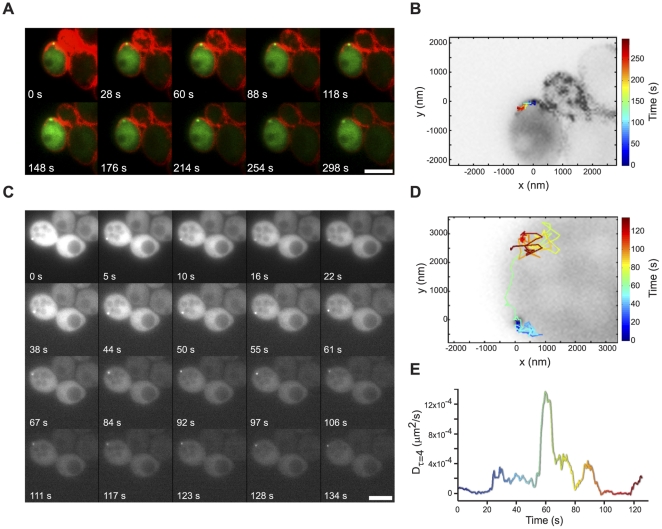
2D dynamics of actin patch mRNA localization.(A) Montage of a time-lapse video of LAS17:MS2 (green) localization in a haploid, early S phase cell with actin patch accumulation at the presumptive bud indicated by FM4–64 staining (red). Scale bar is 2 µm. (B) The trajectory of the mRNA particle in panel (A) is shown on a grayscale image of the first timepoint (0 s) with black-white inversion. Time is encoded by color in the heatmap. (C) Montage of a time-lapse video of LAS17:MS2. Scale bar is 5 µm. Brightness of the latter timepoints in the montage was adjusted relative to the earliest timepoints for display purposes in order to compensate for photobleaching. (D) The trajectory of the mRNA particle from panel (C) is displayed as in panel (B). (E) Change in the diffusion coefficient of the mRNA particle in panels (C) and (D) over time. The diffusion coefficient for short time lags (τ = 4) is graphed with time encoded by color as in panel (D). D was extracted from 4 non-overlapping segments of the trajectory of length 8.992 s, or 16 timepoints. The highest estimated D value, 0.00138 µm2/s, leads to an approximate standard deviation of 5.63×10−3 µm2/s [135], [136].